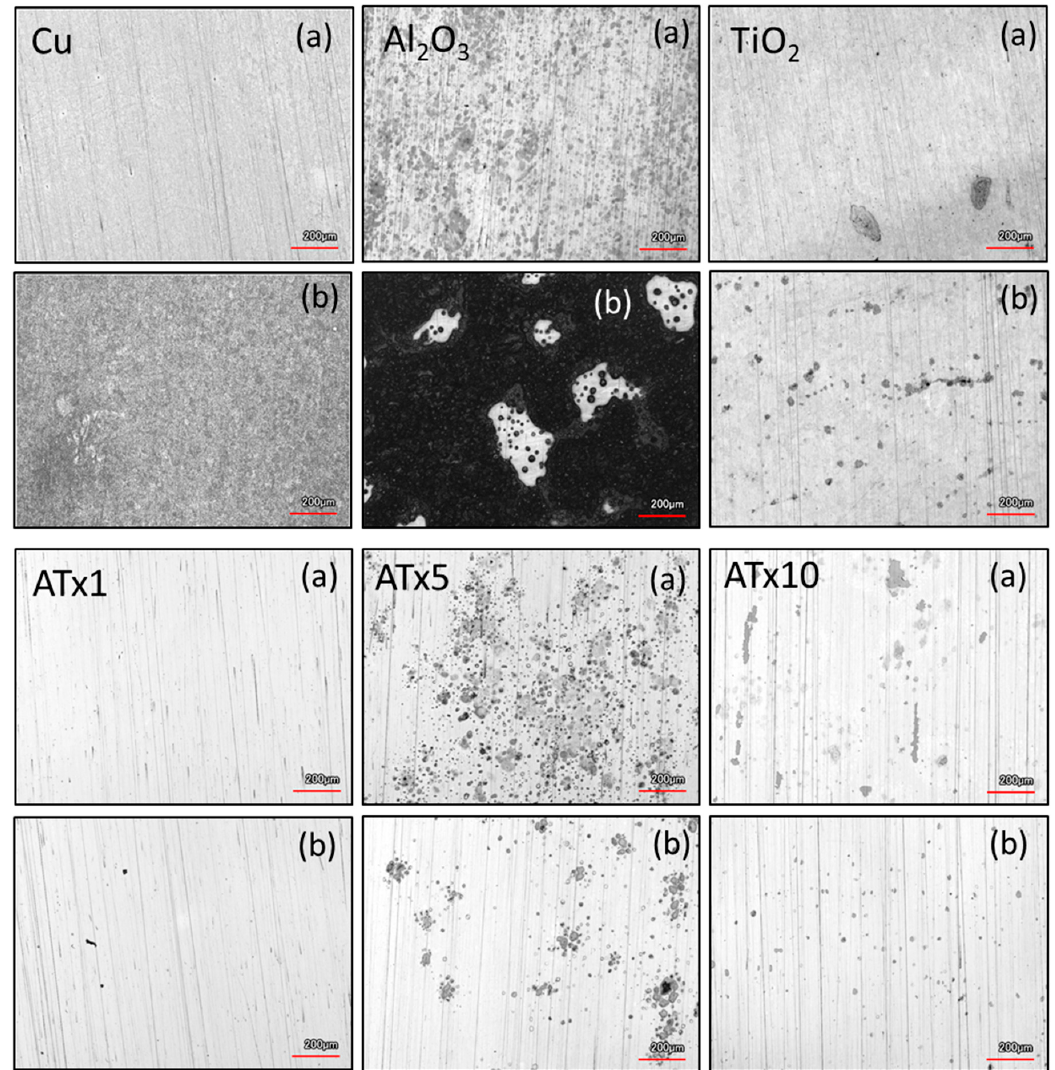
Figure 11. Confocal laser scanning microscope images of uncoated and ALD-coated copper samples after 72-h immersion and EIS testing in ( a ) deoxygenated and ( b ) oxygenated 0.1 M NaCl. Refer to Table 1 for sample descriptions.